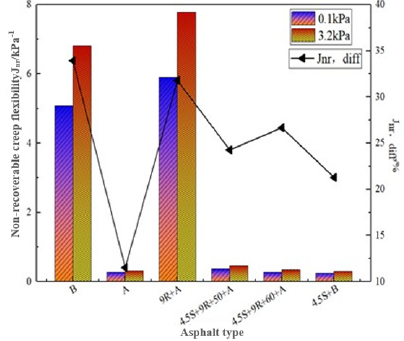
Figure 4. Comparison of J nr for different asphalt types.